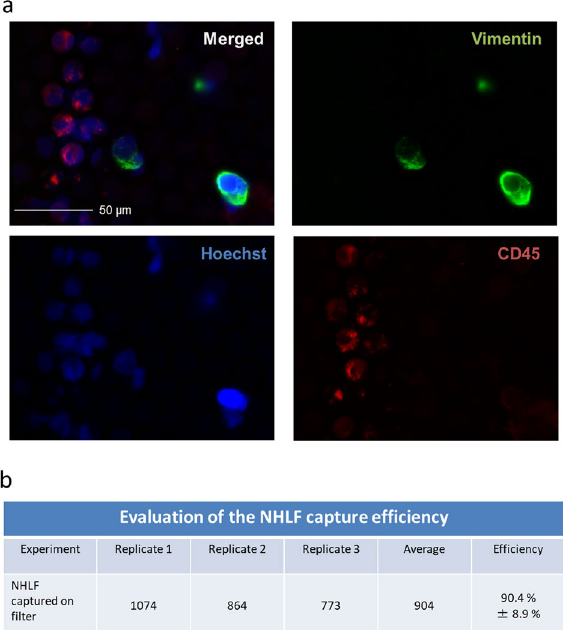
Figure 4. CAF capture test using glass filters. ( a ) CAFs captured on a glass filter. ( b ) Capture efficiency of